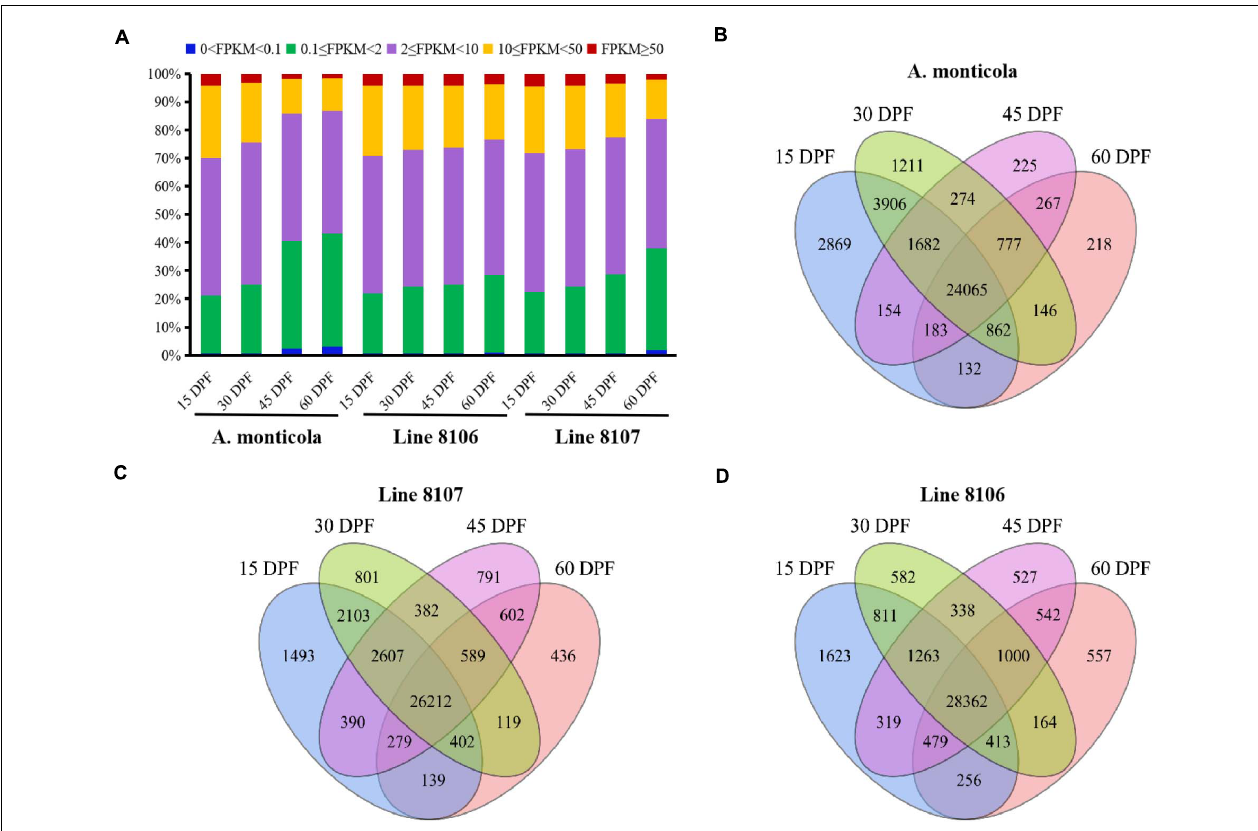
FIGURE 2 | Expressed genes in the three peanut accessions at four seed developmental stages. (A) Proportion of genes expressed at five different levels (based on FPKM) during the four seed developmental stages (15, 30, 45, and 60 DPF) for A. monticola , Line 8106, and Line 8107. Panels (B–D) are Venn diagrams showing the number of genes with shared or stage-specific expression at the four seed developmental stages (15, 30, 45, and 60 DPF) in A. monticola , Line 8107, and Line 8106,